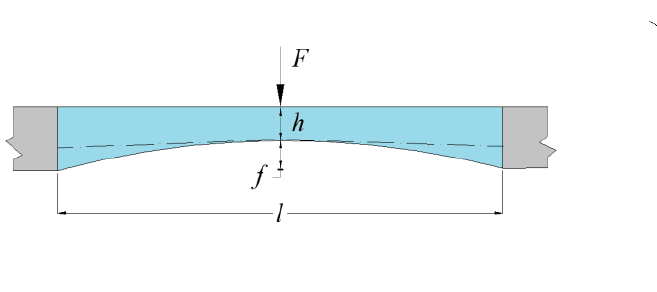
Figure 1. Structure of the reinforced concrete CLS.